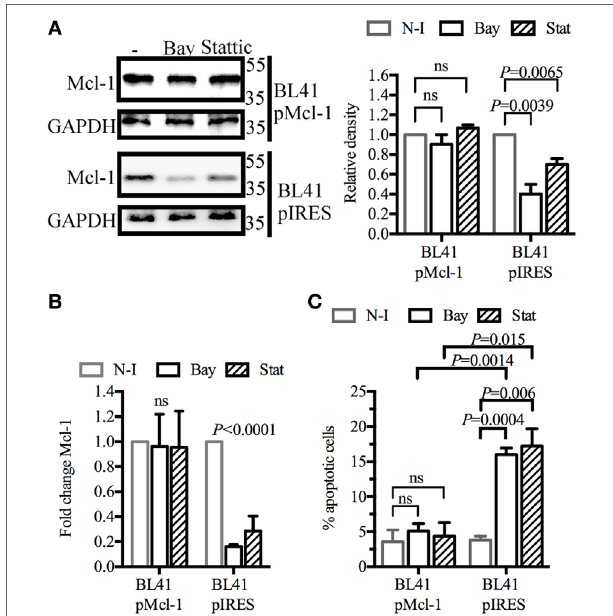
FigUre 4 | Myeloid cell leukemia-1 (Mcl-1) overexpression protects BL41 cells against BAY61-3606-induced apoptosis BL41 cells were transduced with retroviral particles containing an Mcl-1 construct (pMcl-1), or an empty vector (pIRES) as a control. (a) The transduced cells were treated with BAY61-3606 or Stattic (5 µM; 4 h). Mcl-1 protein levels were determined by western blotting, with quantification by protein densitometry and normalization against GAPDH levels. Mean values are shown ( ± SEM, n = 3). (B) Mcl-1 gene expression was determined by RT-qPCR after treatment with BAY61-3606 (5 µM; 4 h) or Stattic (5 µM; 4 h). Mean values are shown ( ± SEM, n = 4), and significant P -values are shown for comparisons with cells not treated with inhibitor. (c) Apoptotic cells were identified on the basis of their extracellular expression of phosphatidylserine, detected by Annexin V staining, and their plasma membrane permeability, assessed by monitoring their uptake of 7-AAD after treatment with BAY61-3606 (5 µM; 8 h) or Stattic (5 µM; 8 h). Mean values are shown ( ± SEM, n = 4). Bay, BAY61-3606; N-I, non-inhibited; ns, not significant; Stat,